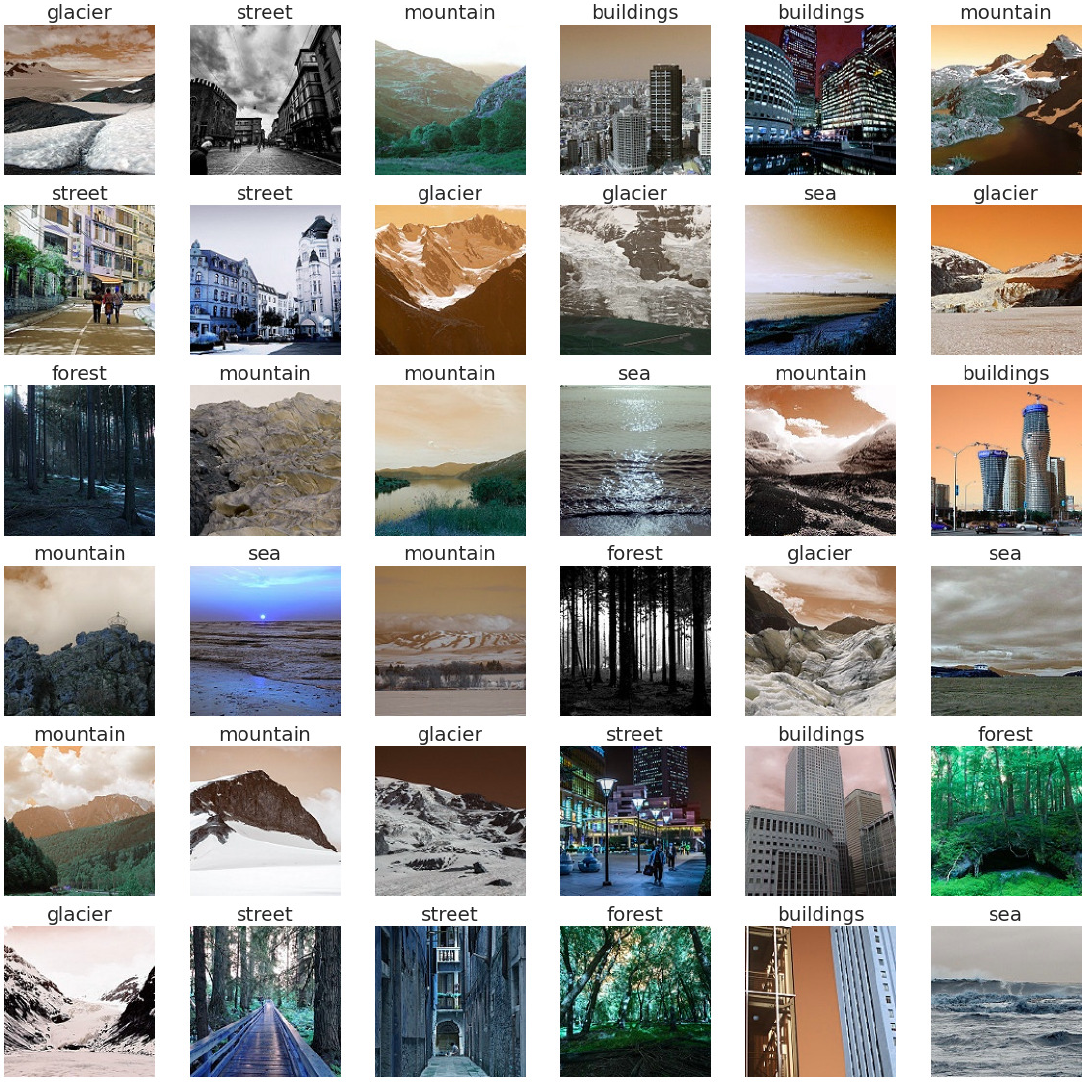
Figure A8. Random predicted images with their labels predicted by our proposed